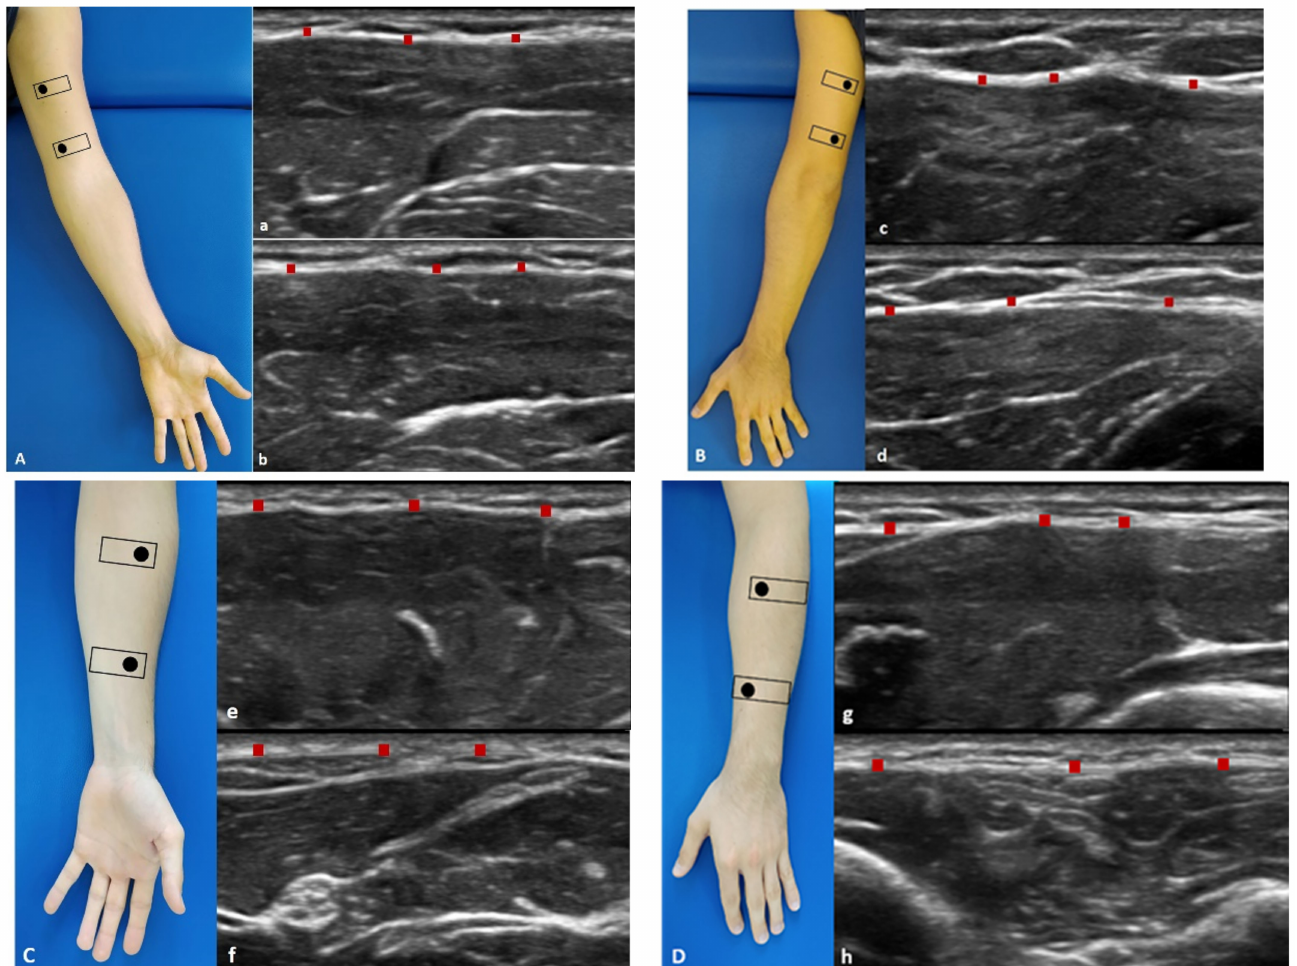
Figure 2. Ultrasound (US) images of the deep fascia of: the anterior region of the arm ( A ) and of the forearm ( C ); the posterior region of the arm ( B ) and of the forearm ( D ). Anterior region ( A , C ) at the levels Ant 1 ( a , e ) and Ant 2 ( b , f ). Posterior region ( B , D ) at levels Post 1 ( c , g ) and Post 2 ( d , h ). Probe: black rectangle. Red dashes: deep fascia. Reprinted with permission from